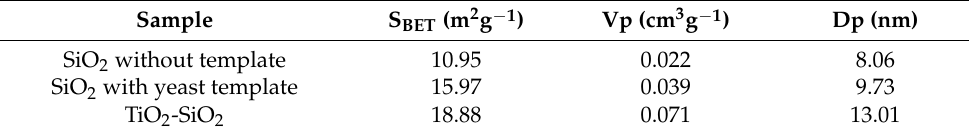
Table 1. Specific surface area and pore size distribution parameters of different samples.